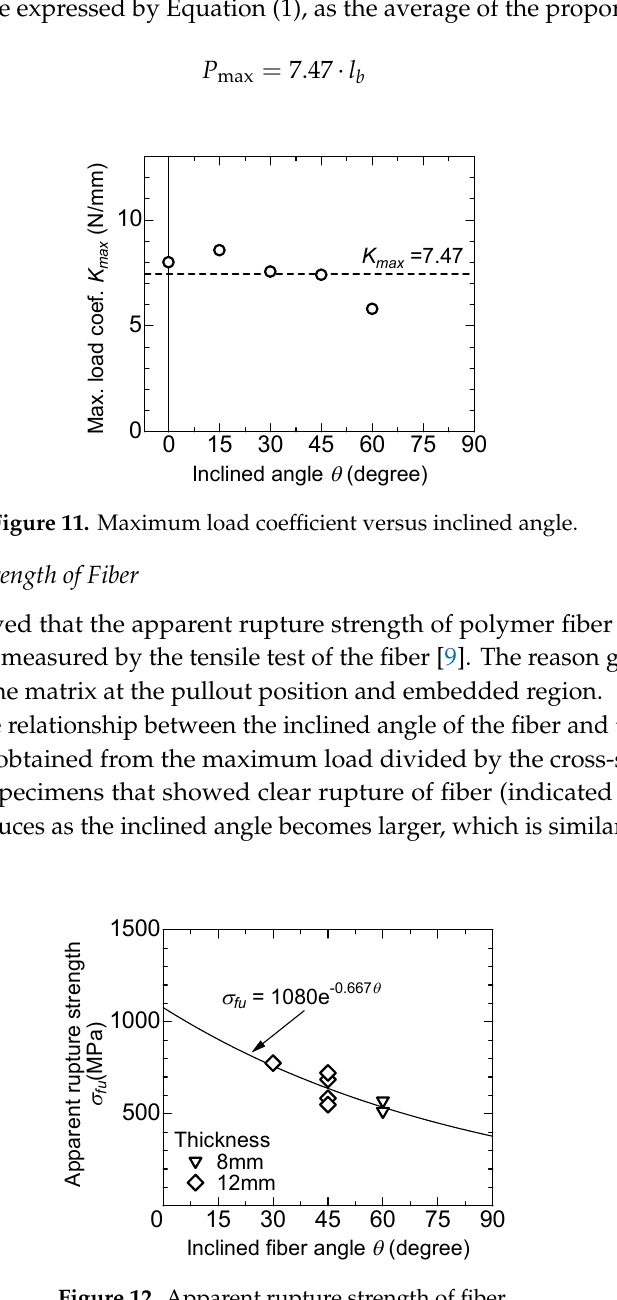
Figure 12. Apparent rupture strength of fiber.